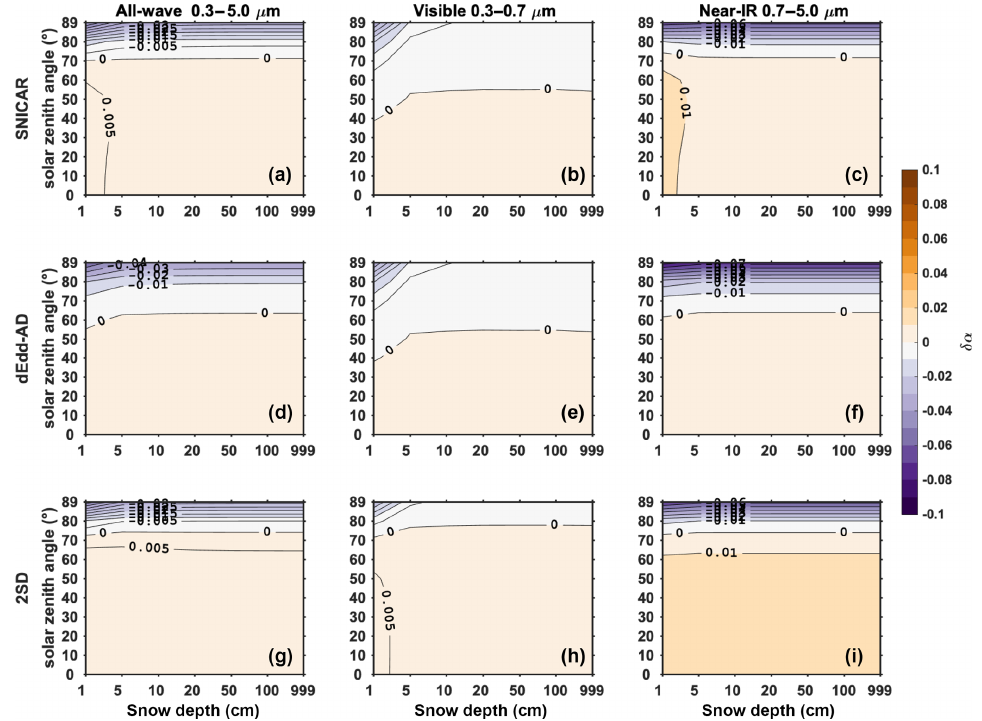
Figure 3. The difference in direct snow albedo ( δα = α 2 − α 16 ) computed using two-stream models ( α 2 ) and using the 16-stream DISORT model ( α 16 ), for various snow depths and solar zenith angles, with a snow grain radius of 100µm. From the top to the bottom, rows are results of two-stream models SNICAR, dEdd–AD, and 2SD. From the left to the right columns are albedo differences of all-wave, visible, and near-IR